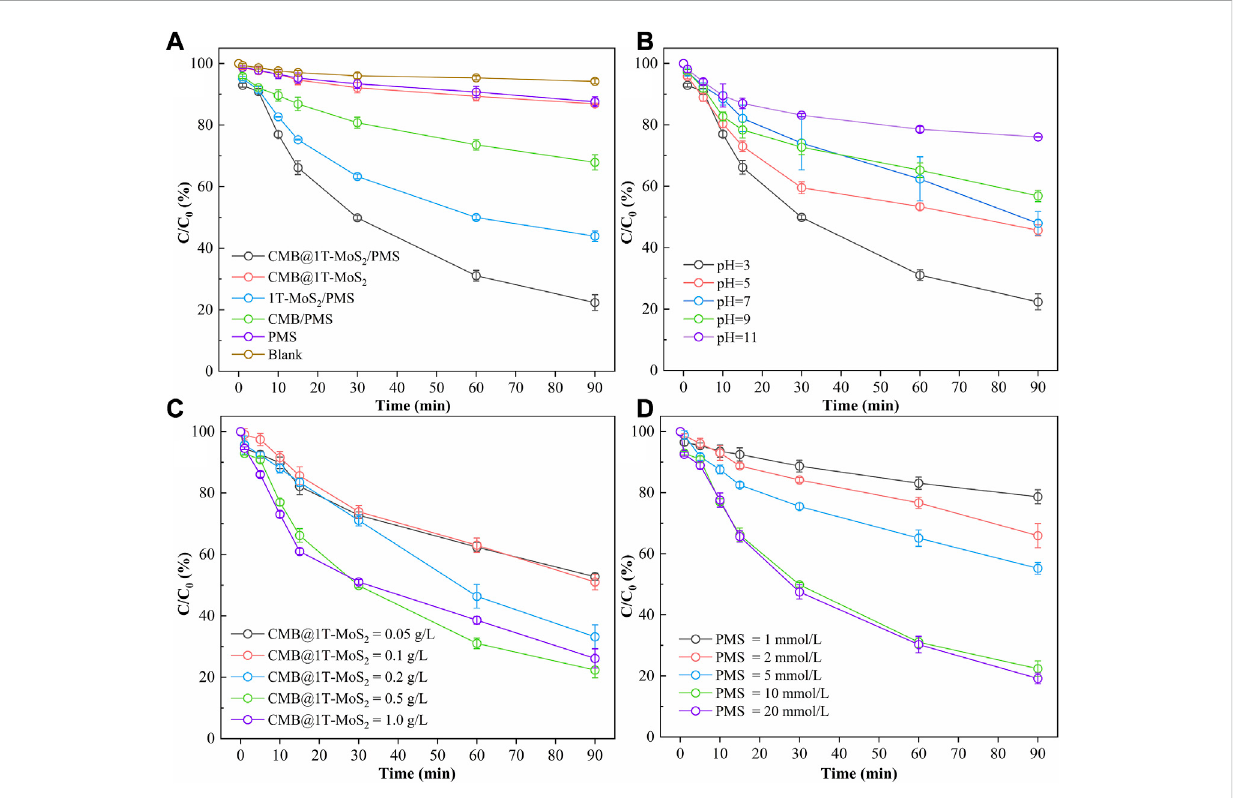
FIGURE 5 In fl uencing factors of the degradation ef fi ciency of DMP (A) different reaction processes (PMS = 5 mmol/L, CMB@1T-MoS 2 = 1T-MoS 2 = CMB = 0.05 g/L, initial pH = 3), (B) initial pH (PMS = 5 mmol/L, CMB@1T-MoS 2 = 0.05 g/L), (C) CMB@1T-MoS 2 dosage (PMS = 5 mmol/L, initial pH = 3) and (D) PMS dosage (CMB@1T-MoS 2 = 0.05 g/L, initial pH =